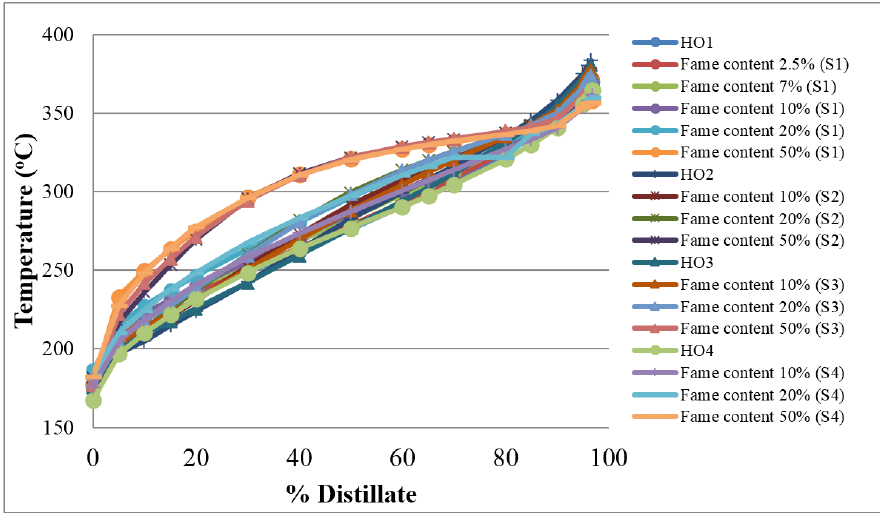
Figure 3. Distillation curves of oil samples.